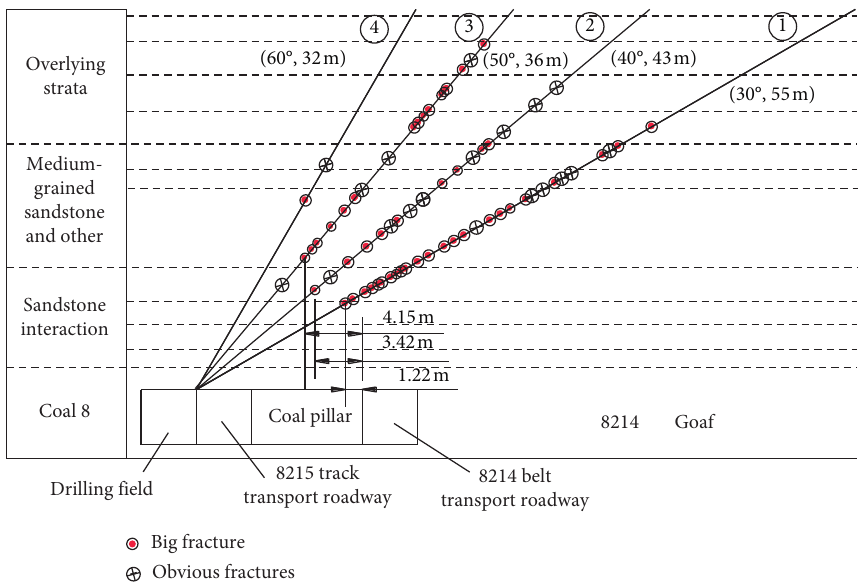
Figure 8: Probing results of the main roof fracture location.